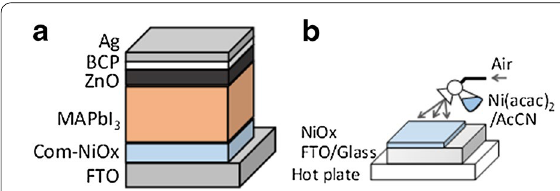
Fig. 1 a Schematic of all inorganic inverted perovskite solar cell structure of